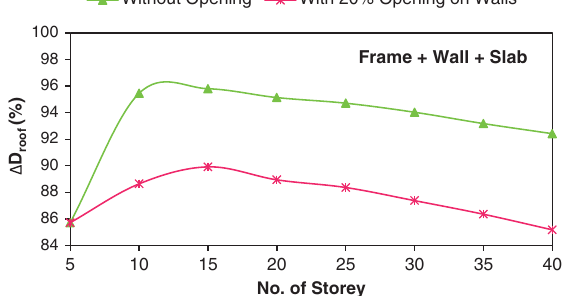
Fig. 5. Increment of roof displacement, Δ D roof , in effect of wall openings and